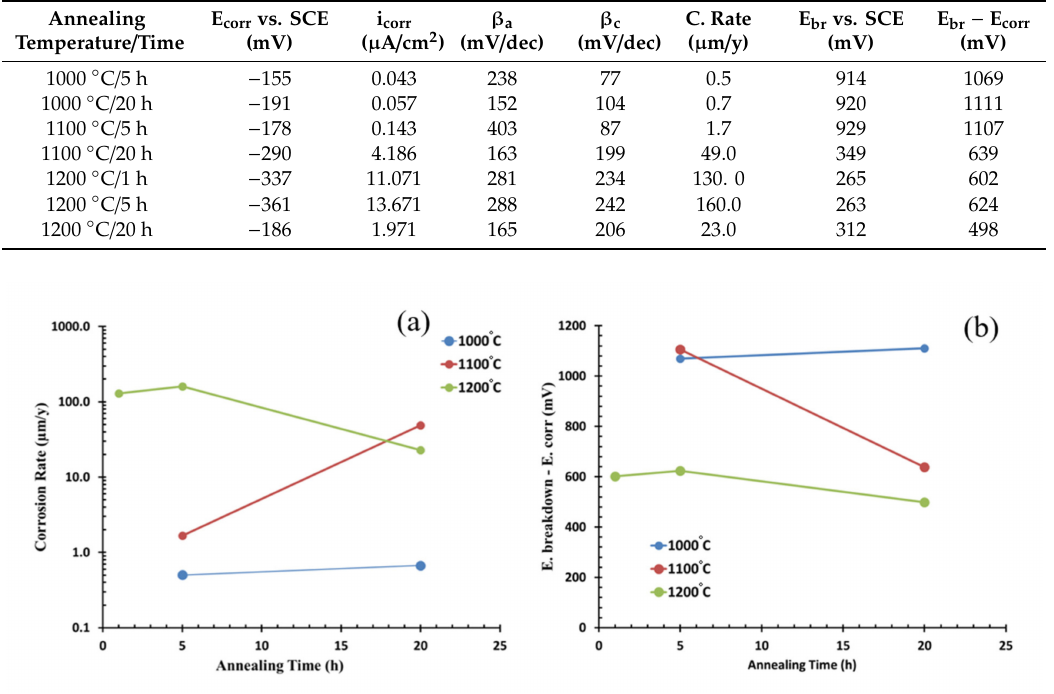
Figure 8. Corrosion rates ( a ) and the breakdown and corrosion potential di ff erences ( b ) versus annealing temperature for the OPH1 samples plotted from data of Table